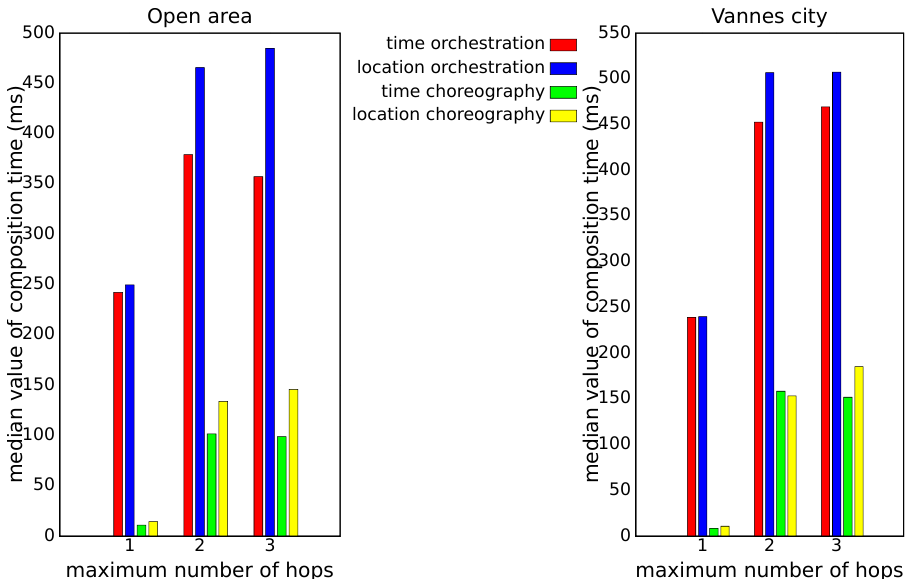
Figure 7. Median of invocation time against the number of hops between service clients and service providers.